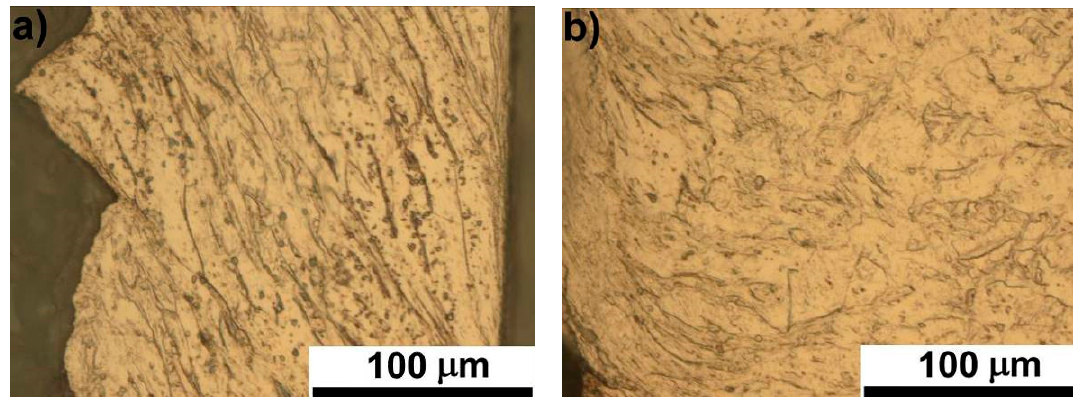
Figure 3. Sample views of the microstructures of the titanium Gr4 chips: ( a ) coarse chips obtained by turning—variant V2, ( b ) coarse chips obtained by milling—variant V4.